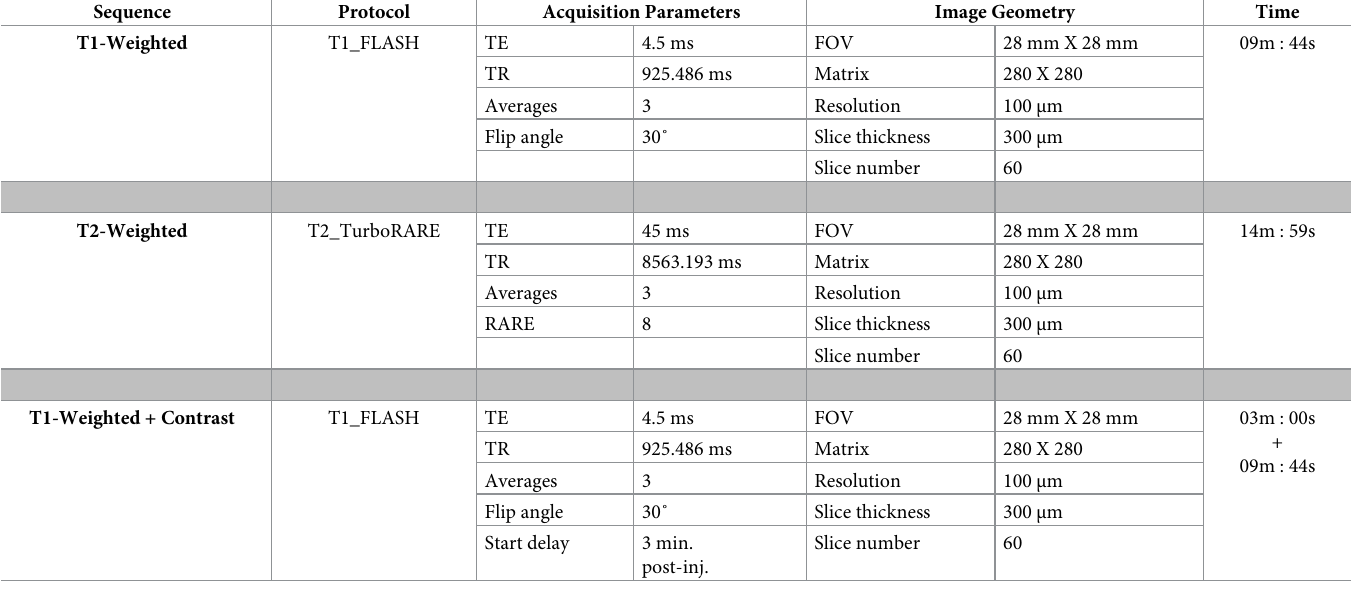
Table 3. Clinically-driven scan program for preclinical MR imaging of soft tissue sarcomas of the extremity.